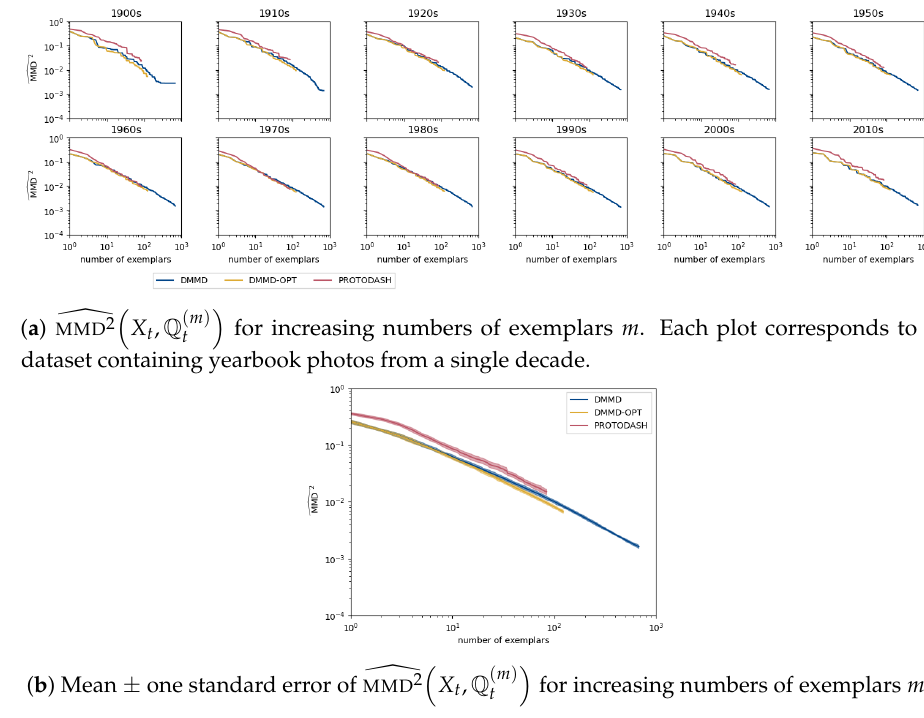
Figure 4. Evaluating how coreset quality varies with number of exemplars, for dependent MMD coresets generated using three algorithms, on 12 yearbook